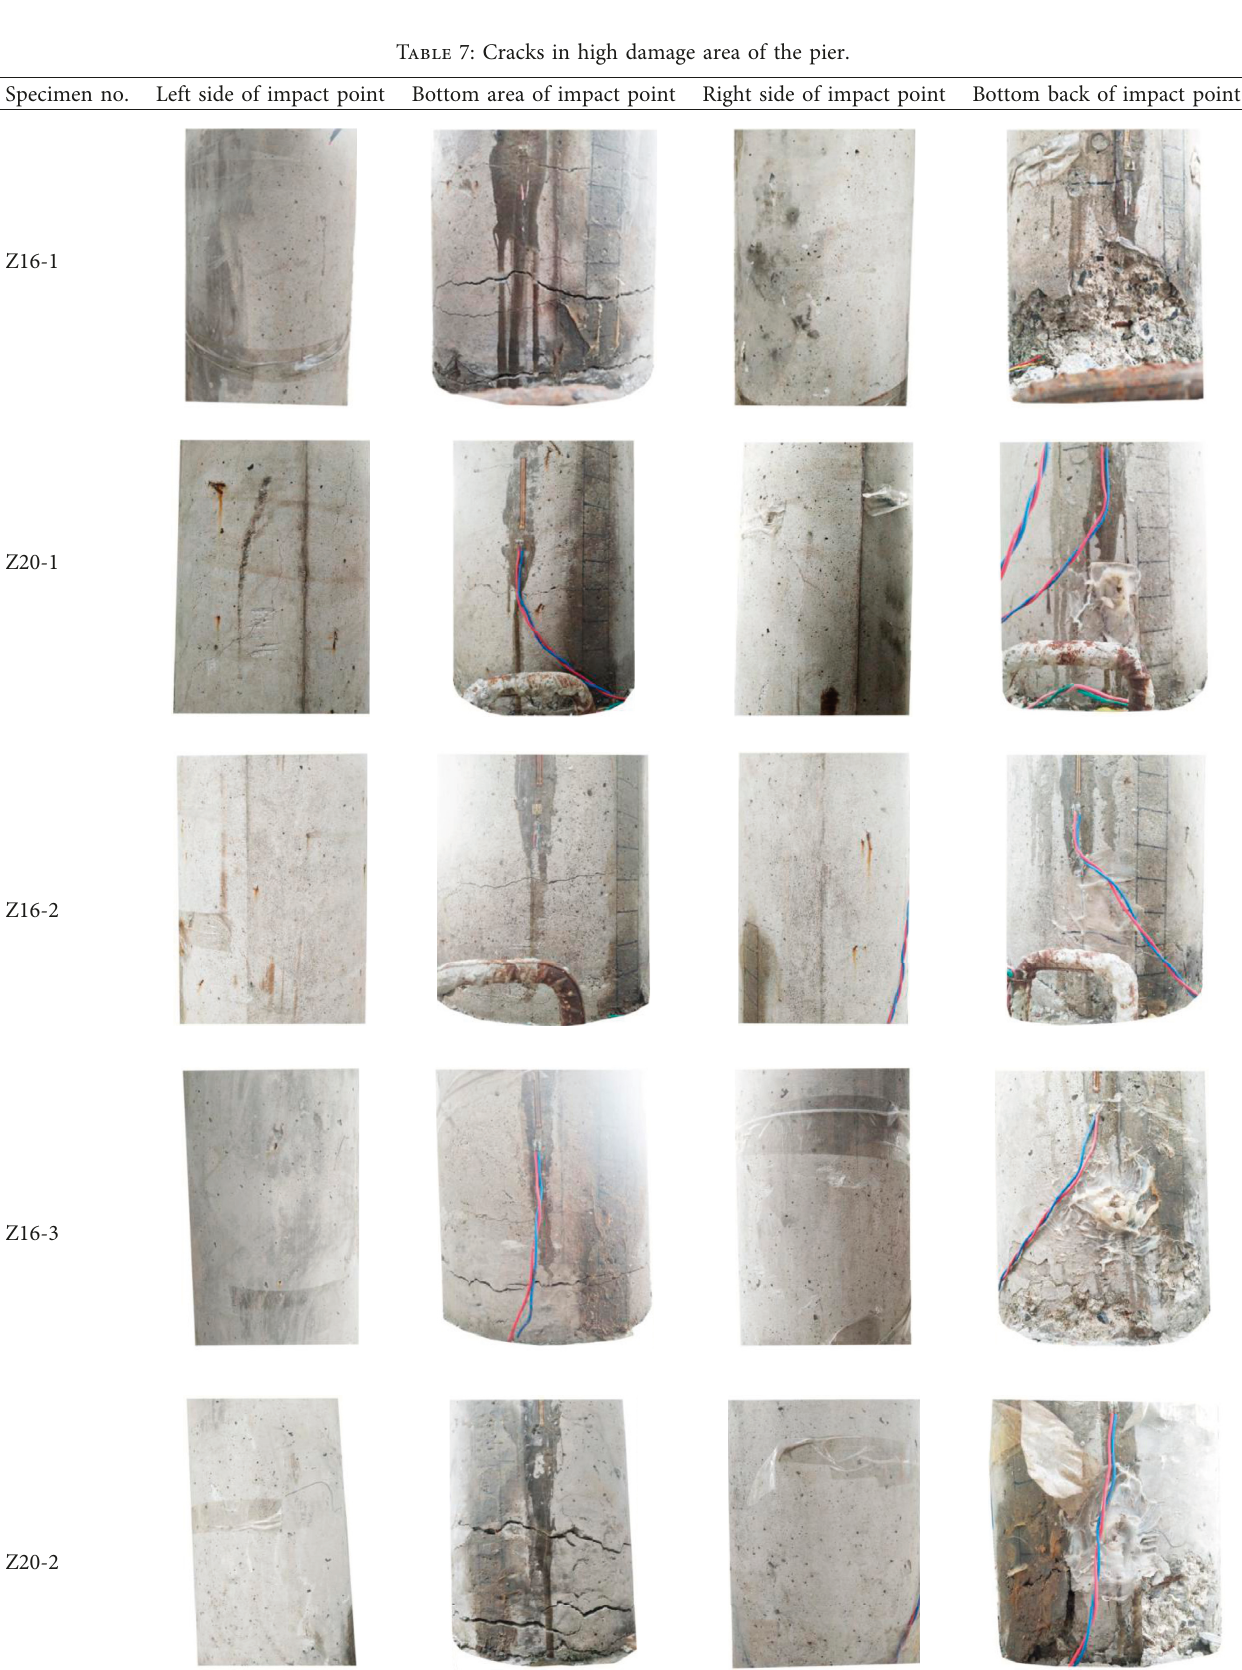
Table 7: Cracks in high damage area of the pier.